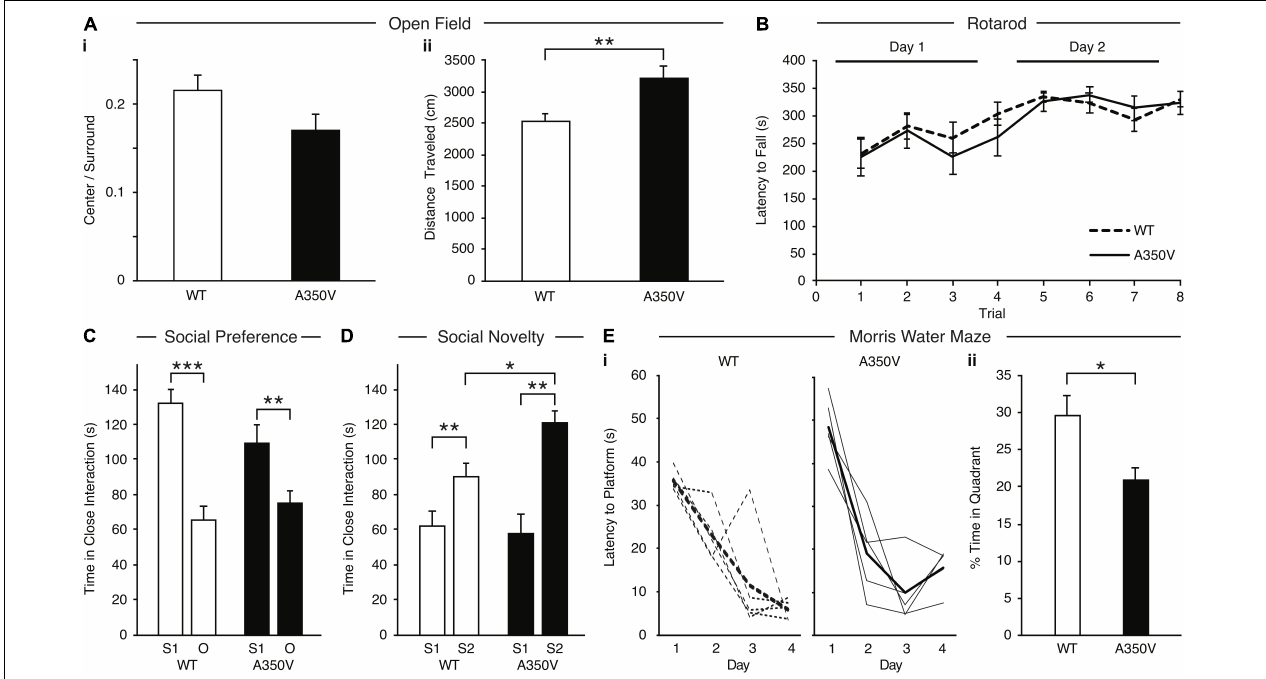
FIGURE 9 | Behavioral phenotype of A350V IQSEC2 mouse model. (A) A350V display normal levels of anxiety-like behavior (i) and increased locomotion activity in an open field test (ii) ( n = 13 wild type and A350V IQSEC2 mice). (B) Intact motor coordination in A350V relative to WT tested by the Rotarod test expressed as an equivalent learning curve and retention across two days in the two groups ( n = 13 wild type and A350V IQSEC2 mice). (C) Duration of time spent in close interaction with Stranger 1 (S1) and an object (O) in the three-chamber social preference test demonstrating both A350V and WT preferred interacting with S1 although this preference was less pronounced in A350V ( n = 13 wild type and A350V IQSEC2 mice). (D) Preference for social novelty expressed as the duration of time spent in close interaction with a previously encountered stranger animal (S1) relative to a novel stranger animal (S2) revealed a tendency to spend more time with S2 in WT and A350V, with significant enhancement of this preference for social novelty in A350V mice ( n = 12 wild type and 9 A350V IQSEC2 mice). (E) Learning and memory deficits in A350V mice shown by the latency to reach the hidden platform during training (i), shown for individual animals ( thin lines ) and averaged across the group ( thick line ) separately for WT and A350V mice and the percentage time spent in the target quadrant in a Morris water maze test (ii) ( n = 5 wild type and A350V IQSEC2 mice). Data indicate means ± SEM. ∗ p < 0.05, ∗∗ p < 0.01, ∗∗∗ p <